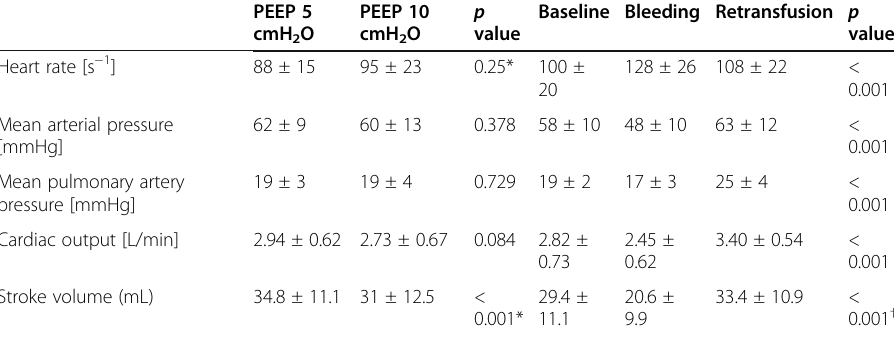
Table 1 Baseline hemodynamics per